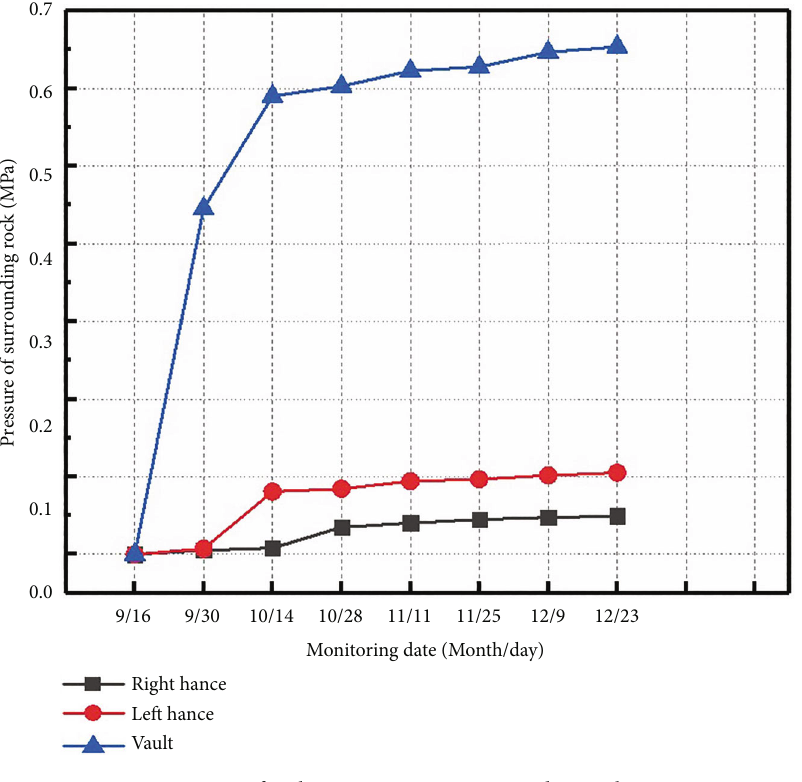
Figure 12: Curve of real-time monitoring surrounding rock pressure. Table 5: Comparison between calculated results and monitoring